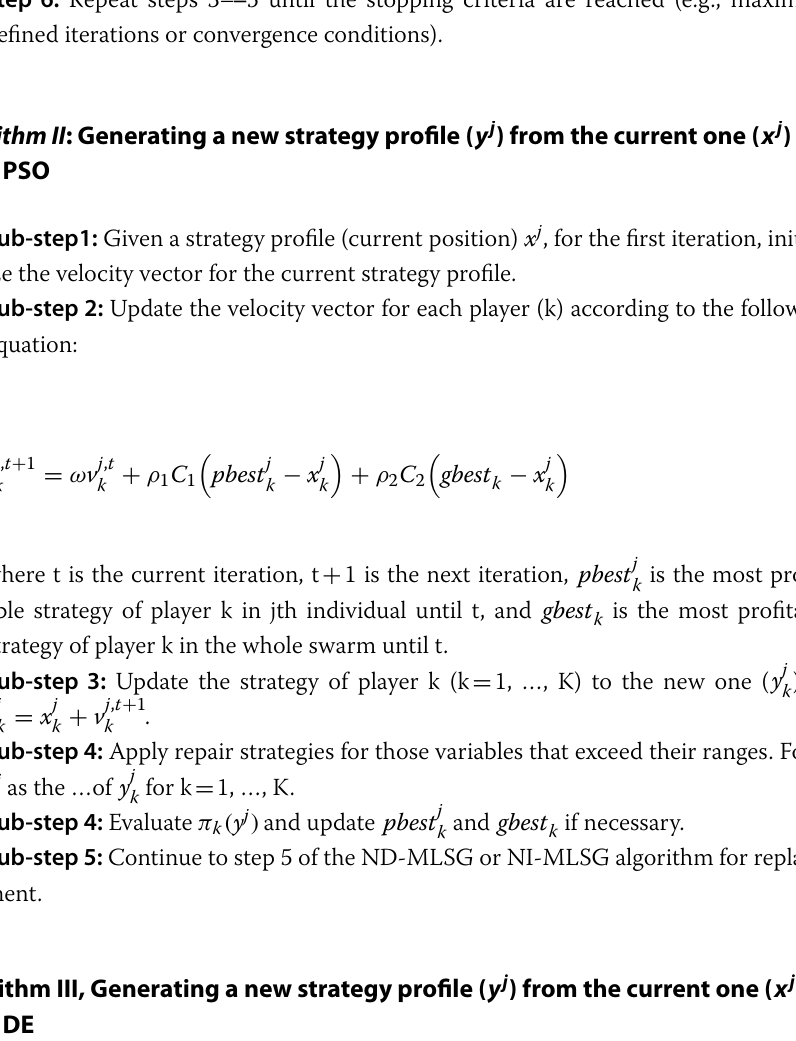
Algorithm III, Generating a new strategy profile ( y j ) from the current one ( x j ) using